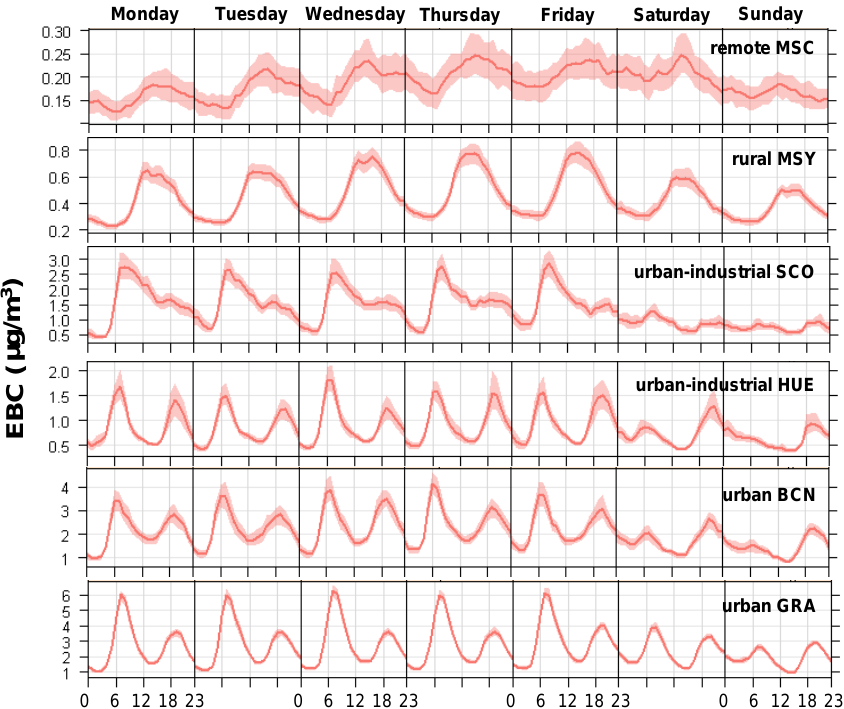
Figure 9: Mean diurnal patterns of EBC at different environments in Spain. Shaded Fig. 9. Mean diurnal patterns of EBC for the different week and weekend days at different environments in Spain. Shaded areas represent areas represent 95 % confidence interval in the mean. 95% confidence interval in the